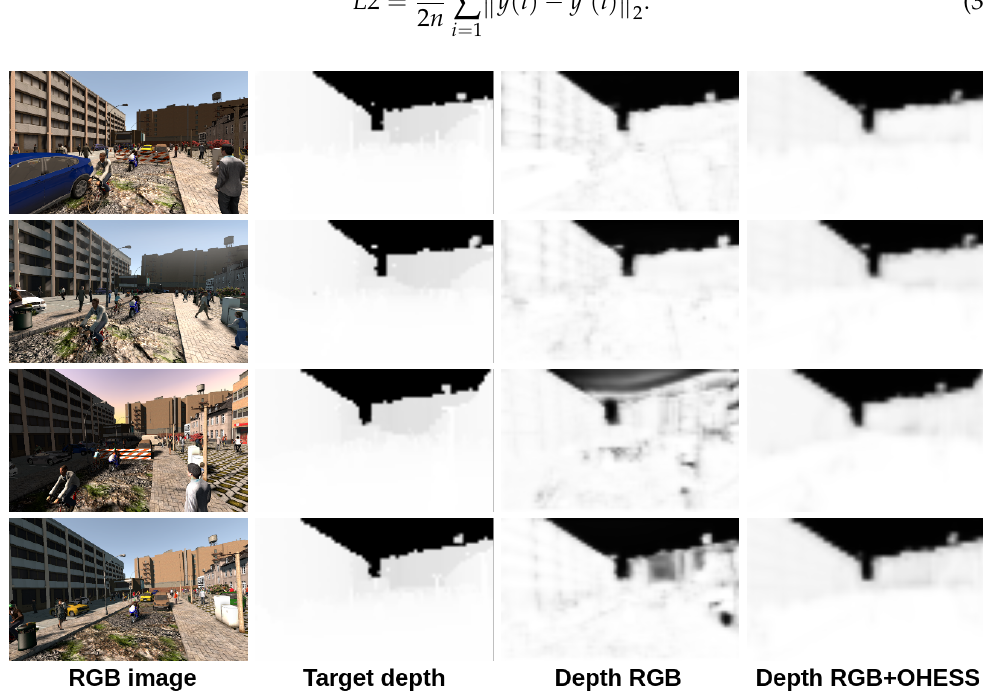
Figure 11. Results obtained with the SCRX CNN model on the 2016 SYNTHIA dataset.